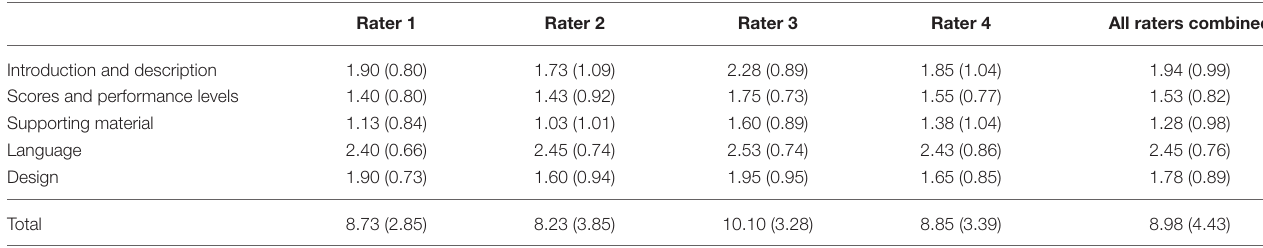
TABLE 1 | Mean ratings by domain and